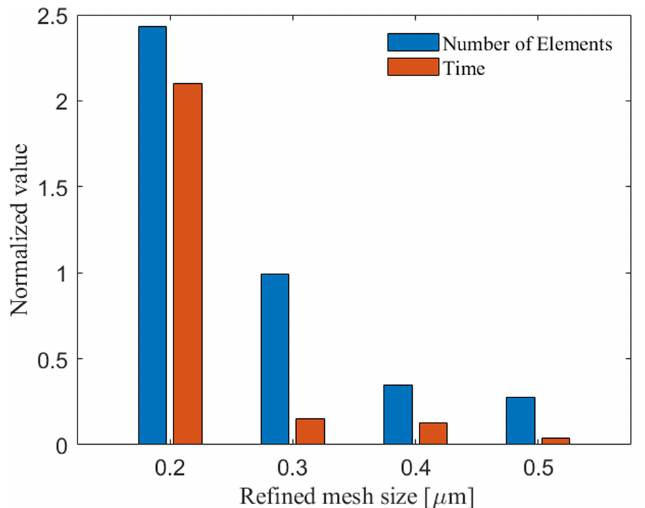
Figure 2. Number of elements and computational time for different refined mesh sizes (0.2, 0.3, 0.4, and 0.5 µ m) using an ALE FEA framework at the particle-matrix contact